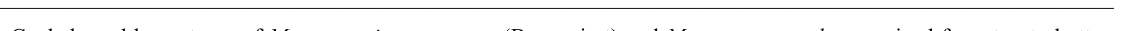
Fig. 5. Cephala and hypostoma of Mucronaspis mucronata (Brongniart) and M. mucronata s.l. , organized from top to bottom following their appearance in the Stirnas-18 drill core, Latvia. A(cid:150)G , morph E: A, GIT 585-13-1, dorsal view of a fragmentary cranidium possibly belonging to this type, showing narrow S3 lobes and the relatively anterior position of the median depression of the frontal lobe (897.6 m); B, G, GIT 585-12-5, dorsal and tilted posterolateral views of an incomplete hypostome (899.5 m); C, GIT 585-14-1, ventrally exposed cephalon (898.7 m); D(cid:150)F, GIT 585-12-3, GIT 585-12-4, tilted anterolateral, anterior and dorsal views of a large cephalon together with a much smaller one (899.5 m). H , I , morph D: GIT 585-9-1, tilted anterolateral and dorsal views of an incomplete cephalon with pyritized exoskeleton (906.8 m). J(cid:150)L , morph C: GIT 585-8-1, two anterolateral views and a dorsal view of a fragmentary cephalon showing a wide anterior border as observed in M. mucronata kiaeri of the Oslo Region (908.1 m). M(cid:150)O , morph B: GIT 585-6-1, tilted anterolateral, dorsal and lateral views of an incomplete exoskeleton (908.7 m). P , Q , possibly belongs to morph A, or to an earlier one: GIT 585-2-1, tilted posterolateral and dorsal views of a hypostome showing border-spines diagnostic of the genus Mucronaspis (910.5 m). Scale bars show division in